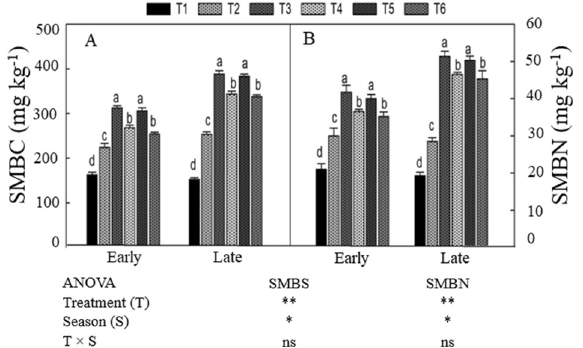
Figure 1. Changes in soil microbial biomass C (SMBC) in the early and late season ( A ) and N (SMBN) during early and late ( B ) under combined organic and inorganic N fertilization. ns: non significant, * p < 0.05, ** p < 0.05. For treatment details please see Table